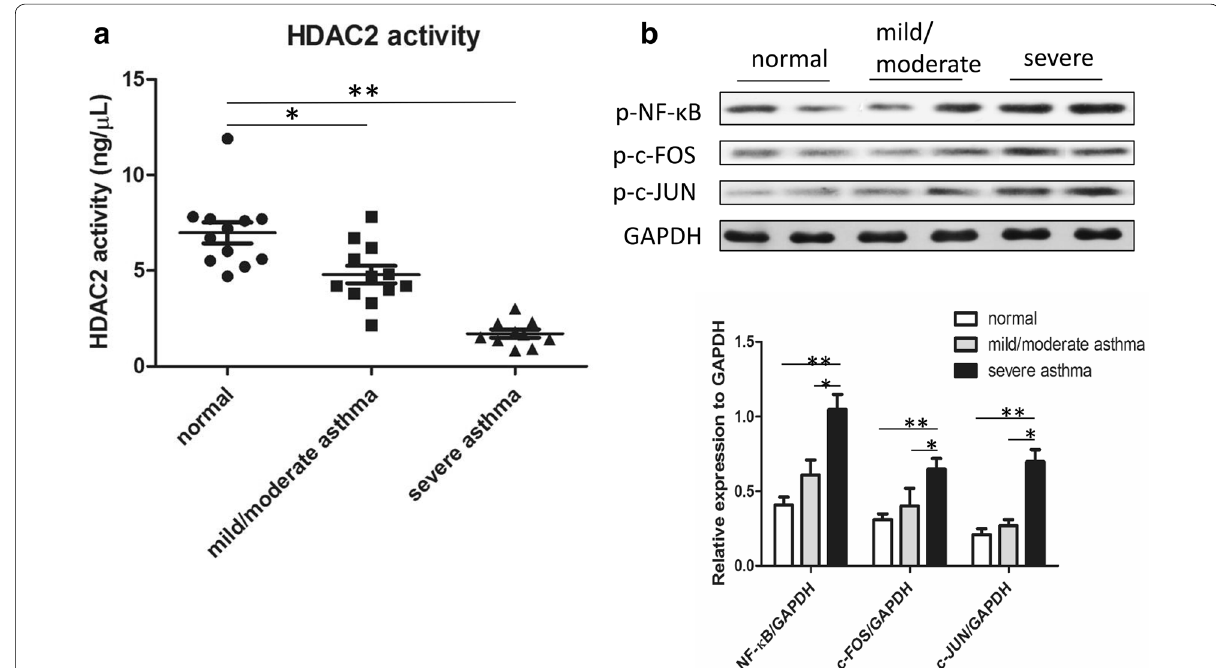
Fig. 2 Molecular mechanisms underlying the dexamethasone insensitivity of PBMCs in severe asthma. a HDAC2 activity in PBMCs from normal controls and patients with mild/moderate or severe asthma [*p < 0.05; **p < 0.01, n respectively)]. b The gene expression of nuclear signaling transcription factors (p-NF-κB, p-c-FOS, p-c-JUN) in PBMCs from normal controls and patients with mild/moderate or severe asthma was analyzed by western blotting. The lower right panel shows the quantitative densitometric analysis. Representative data from at least 3 independent experiments are shown [*p < 0.05; **p < 0.01; n asthma, severe asthma, respectively)]